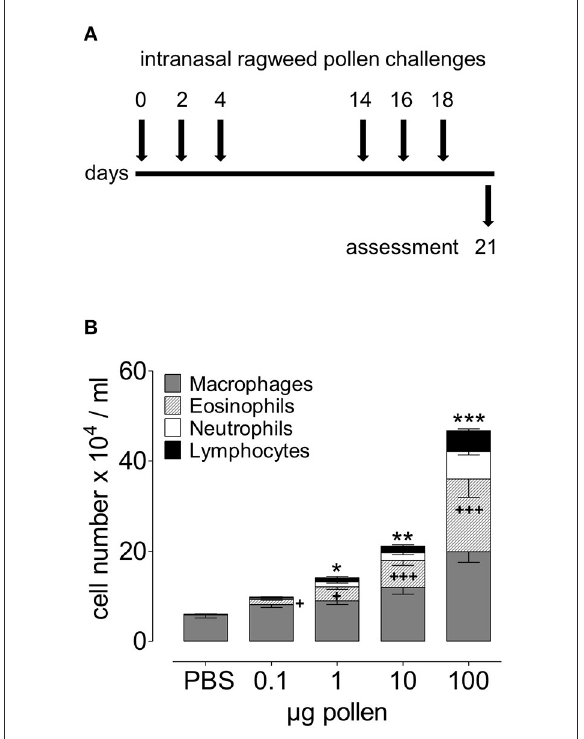
FIGURE2 Dose-dependent acute onset of airway inflammation in response to RWP. (A) Protocol scheme illustrating administration of PBS alone and increasing doses of AG1 RWP 0.1, 1, 10, 100 µ g per 50 µ l PBS without added adjuvant over 21 days. (B) Total inflammatory cell count and differential counts in BAL 72h after the last allergen instillation. Data are presented as mean ± SEM and are representative of at least two experiments; n = 8 . Asterisks indicate significant differences between PBS and RWP challenged groups, for total cells: * p < 0.05, ** p < 0.01, *** p < 0.001, and for eosinophils: + p < 0.05, +++ p < 0.001, one-way